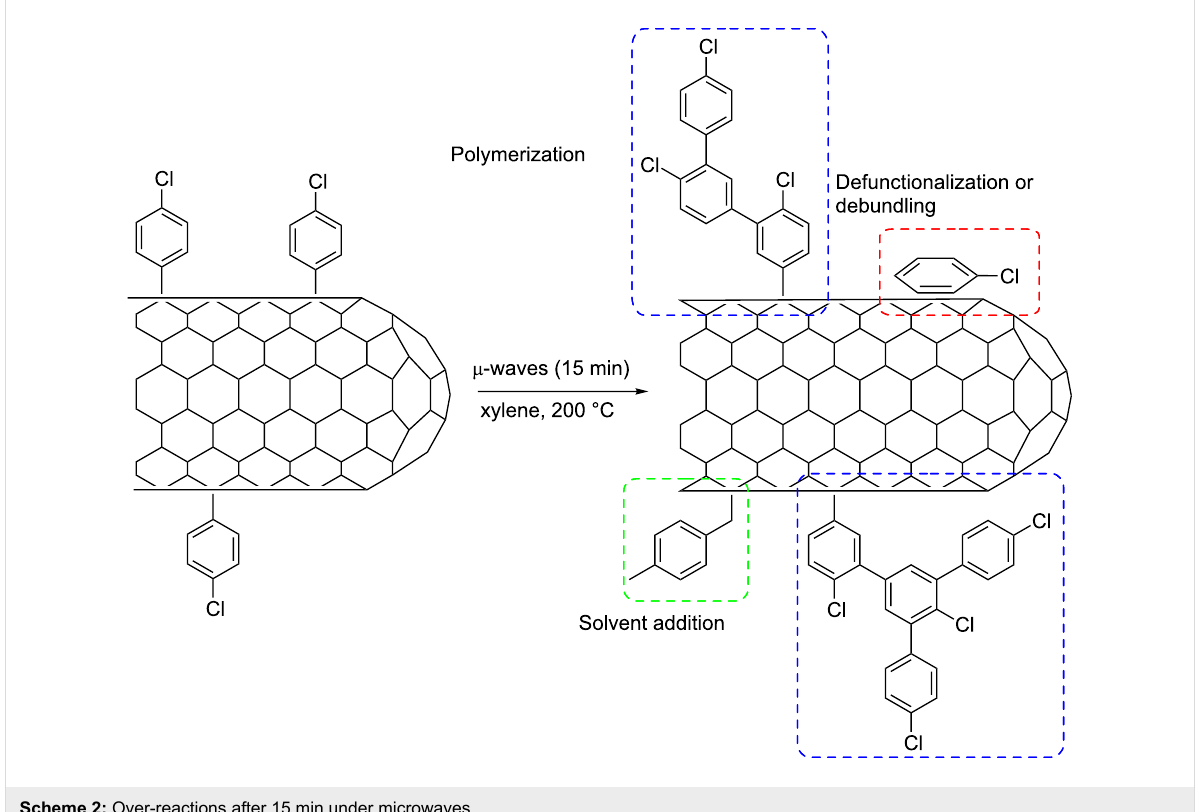
Scheme 2: Over-reactions after 15 min under